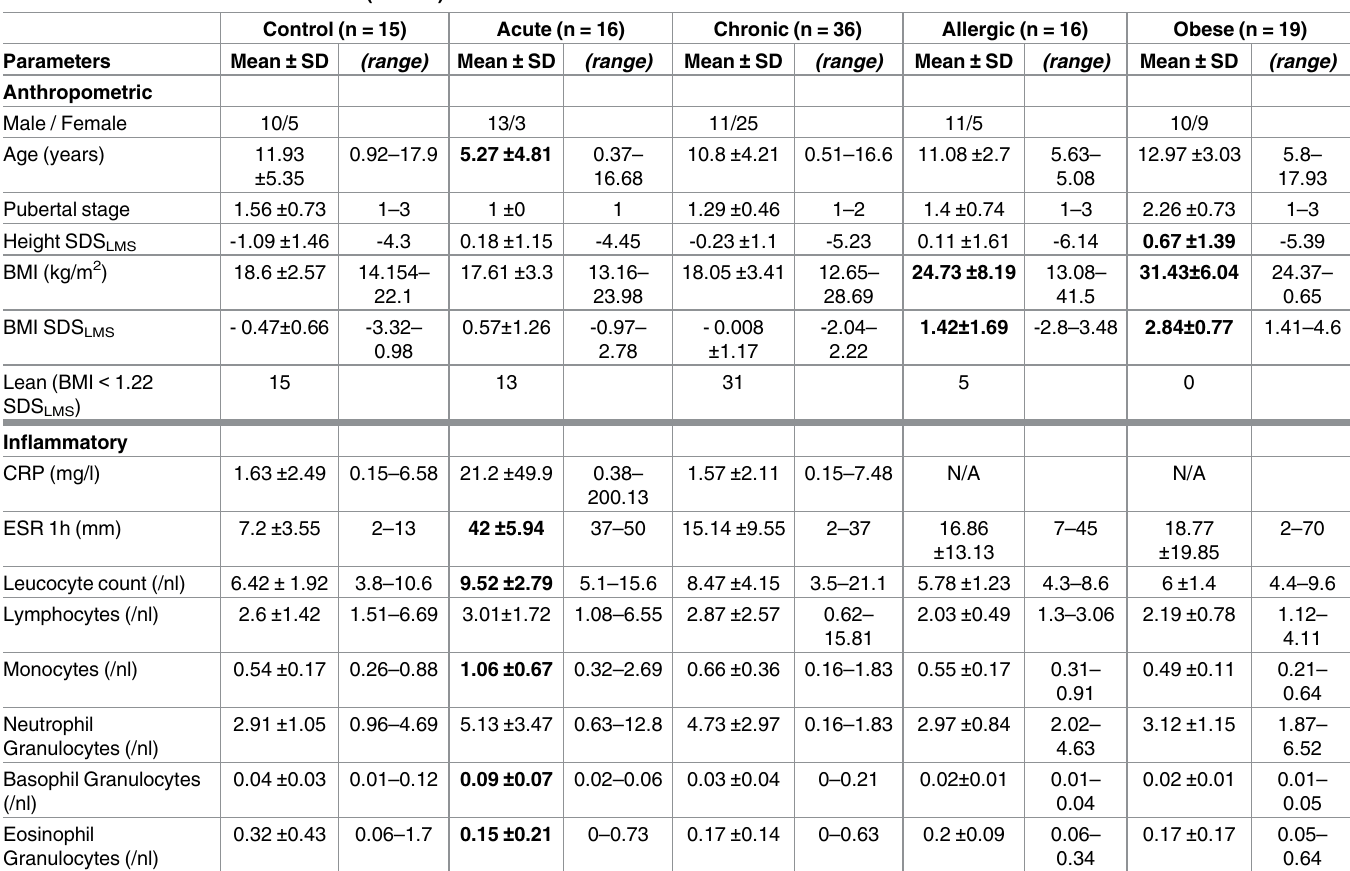
Table 2. Characterization of the cohort (n =